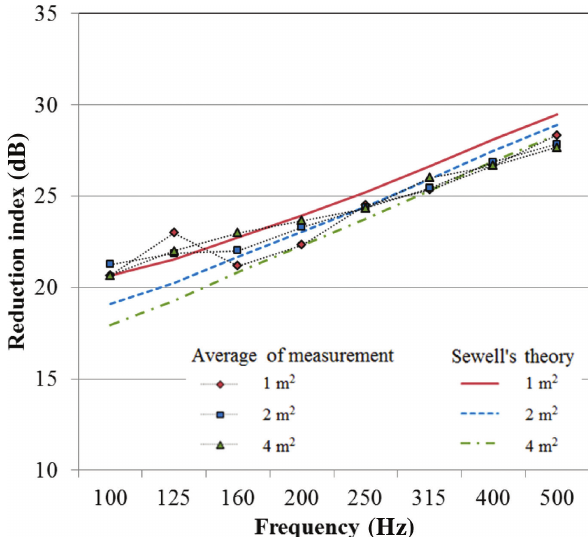
Reduction indices of windows with 5-mm thick glazing. Comparison of experimental and theoretical size